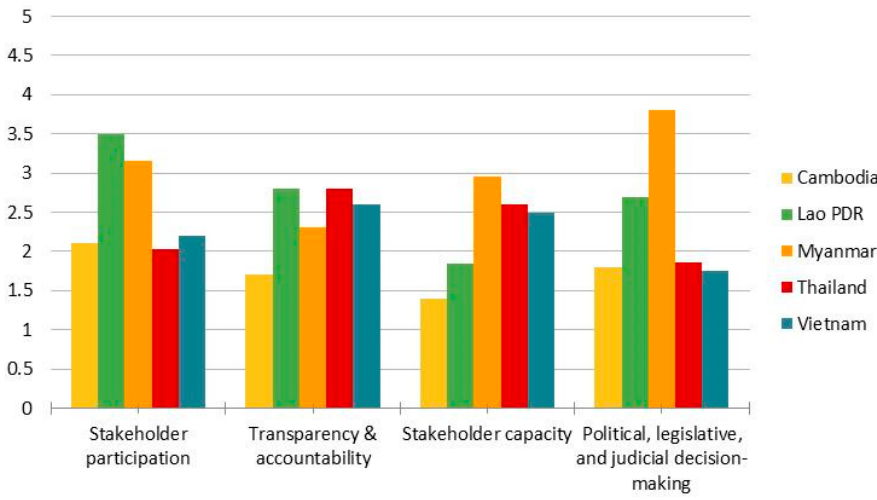
Figure 3. Average score per component of Pillar 2 for each country.